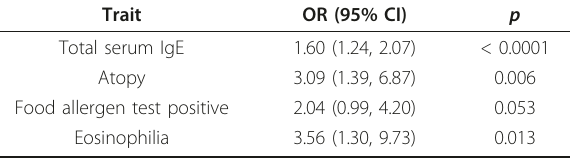
Table 1 Association between asthma and related